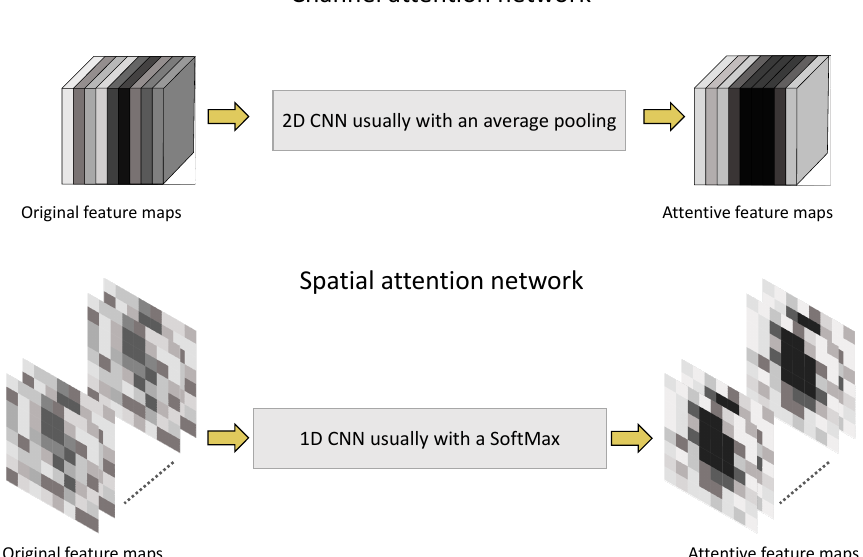
Figure 2. A simple illustration of the channel and spatial attention types/networks, and their effects on the feature maps.